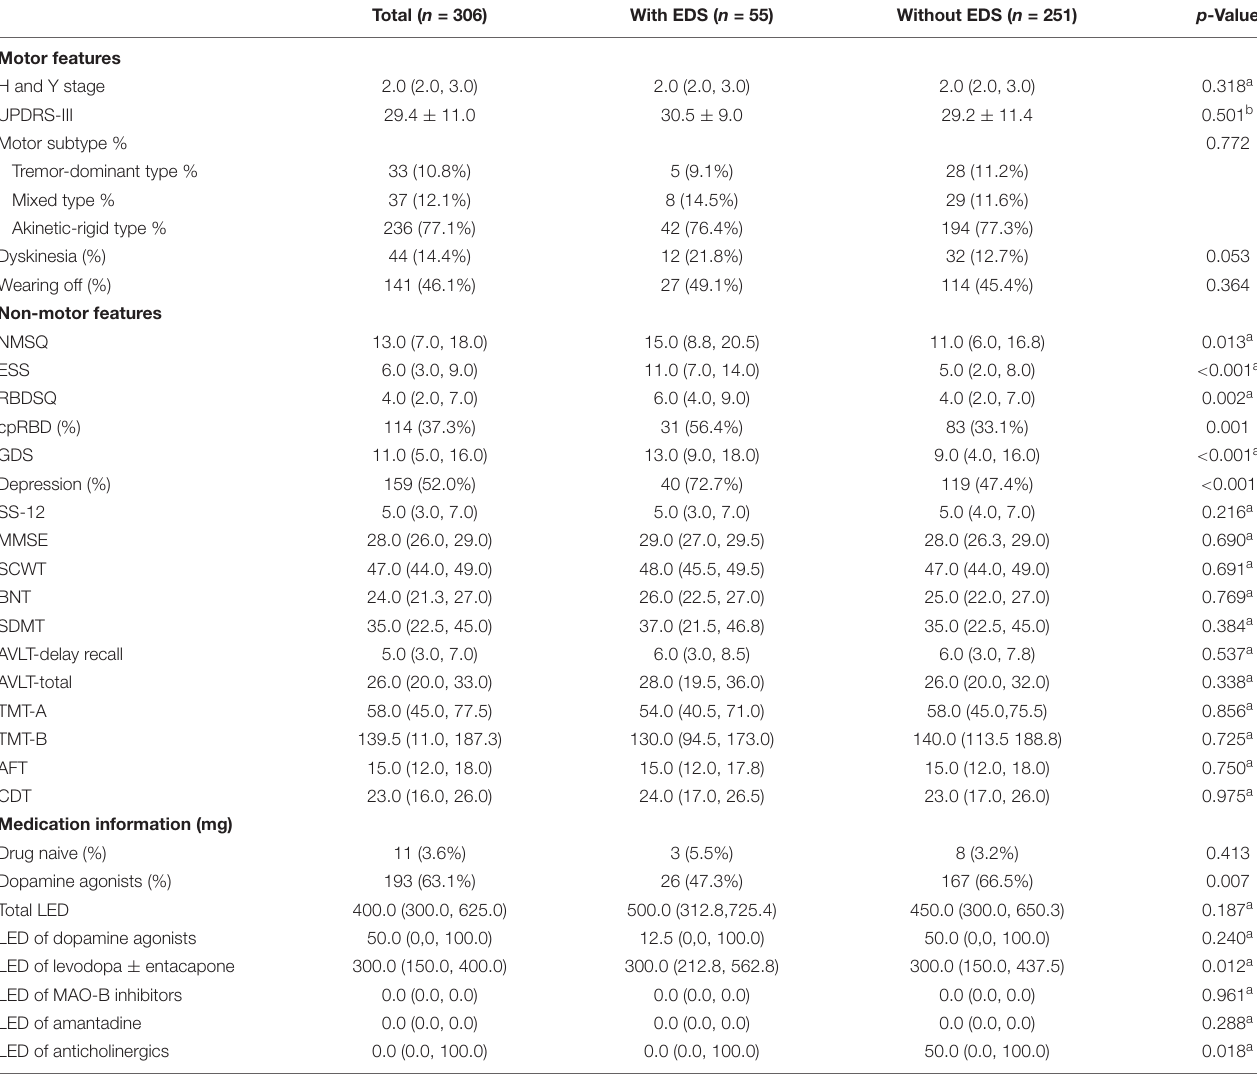
TABLE 2 | Clinical characteristics at 2-year